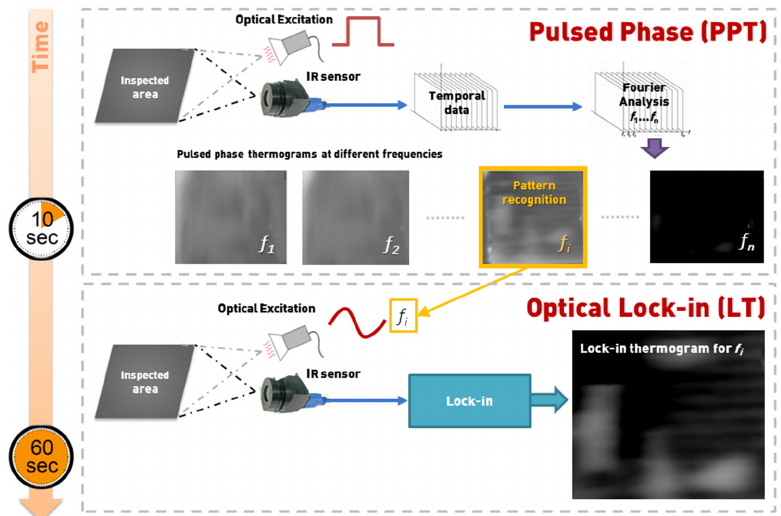
Figure 1. Principle of pulsed phase-informed lock-in (PPI-LT) thermographic strategy. The excitation frequency f i , for optimal thermographic representation of a given damage, is identified in PP-based phase 1 and fed as input for thorough dilatational analysis under lock-in configuration in phase 2.